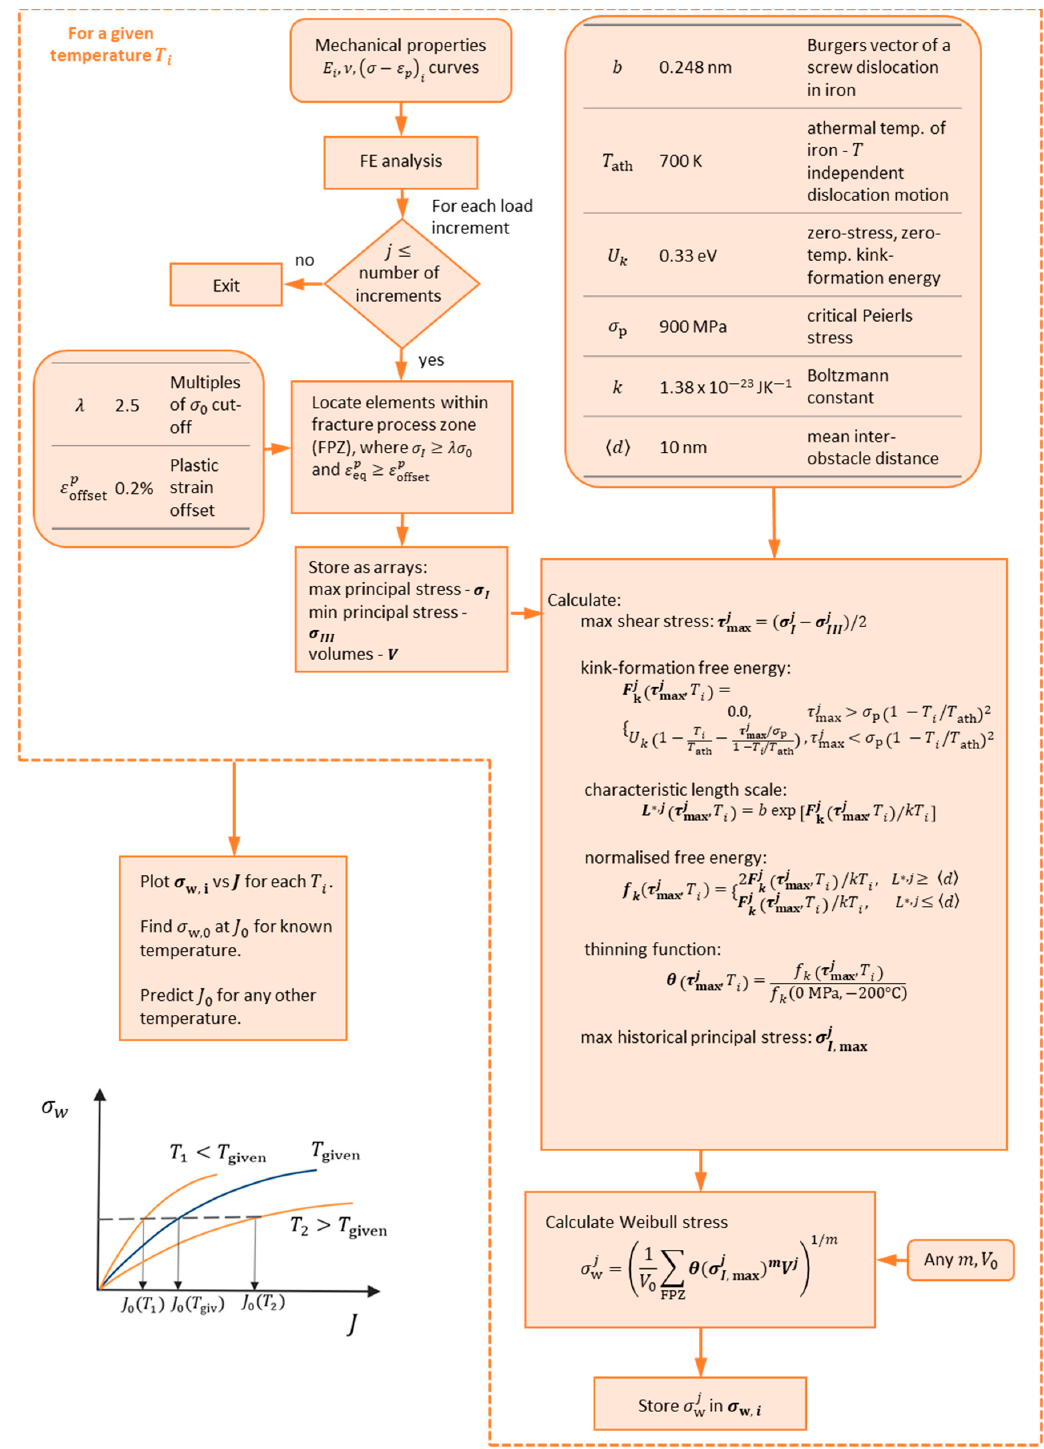
Figure 2. Flow chart of the developed model.